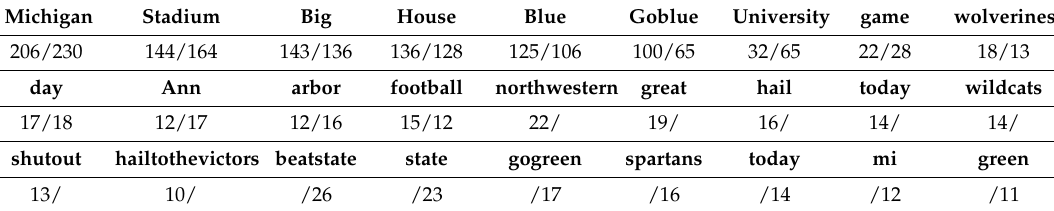
Figure 12. Spatial patterns ( top ) and temporal patterns ( bottom ) of tweets during the football games at Michigan Stadium on 10 October ( left ) and 17 October ( right ) of 2015. Table 6. Word frequency of the football games at the Michigan Stadium on 10 Oct. (*/) & 17 (/*),